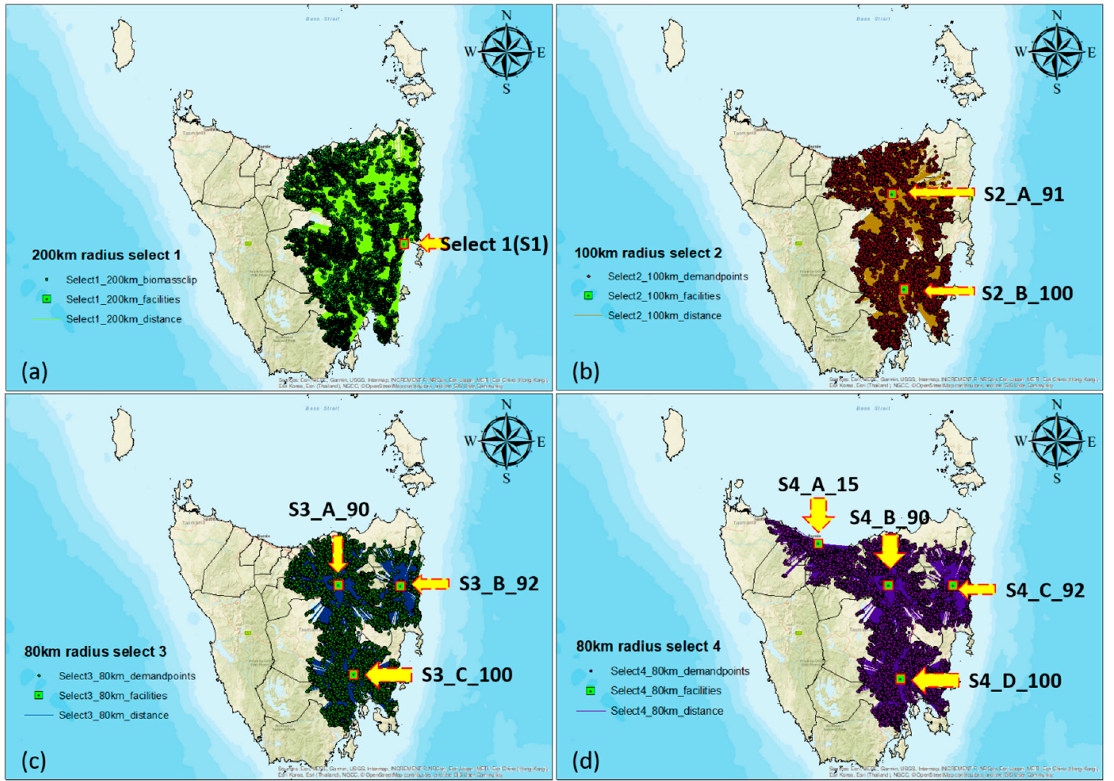
Figure 5. Optimal number and location of potential bioenergy plants. Lines show connections between origin and destinations; Tasmania road network was considered for the analysis; four scenarios were evaluated: ( a ) Scenario 1, 200 km radius selected one biomass facility (location code: Select 1), ( b )